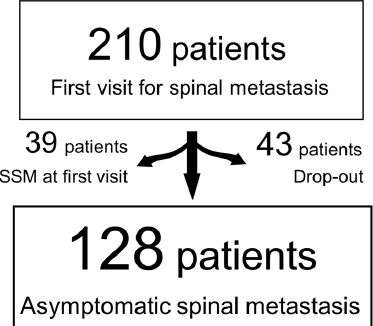
Figure 1. Flowchart of the study design. Table 1. Demographic and clinical factors at study enrollment.